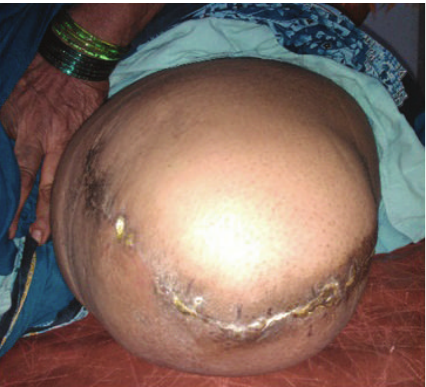
Figure 5: Healed stump after 1